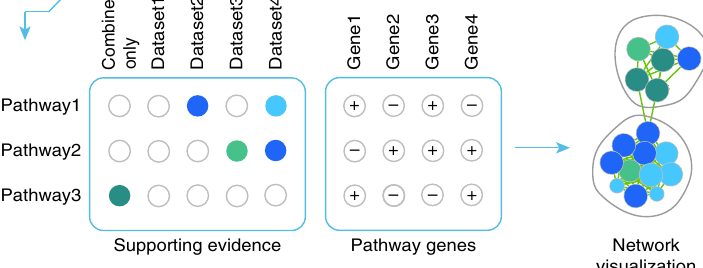
Fig. 1 Method overview. a ActivePathways requires as input (1) a matrix of gene P -values for different omics datasets, and (2) a collection of gene sets corresponding to biological pathways and processes. b In step (1), gene P -values are merged using the Brown procedure and fi ltered to produce an integrated gene list that combines evidence from datasets and is ranked by decreasing signi fi cance with a lenient threshold. In step (2), pathway enrichment analysis is conducted on the integrated gene list using the ranked hypergeometric test that determines the optimal level of enrichment in the ranked gene sub-list for every pathway. In step (3), separate gene lists are compiled from individual input datasets and analyzed for pathway enrichment using the ranked hypergeometric test, to fi nd supporting evidence for each pathway from the integrative analysis. c ActivePathways provides a list of enriched pathways in the integrated gene list, the associated genes with signi fi cant Brown P -values, and annotations of evidence supporting each pathway. Results of ActivePathways are visualized as enrichment maps where nodes correspond to pathways and pathways with many shared genes are connected into networks representing broader biological